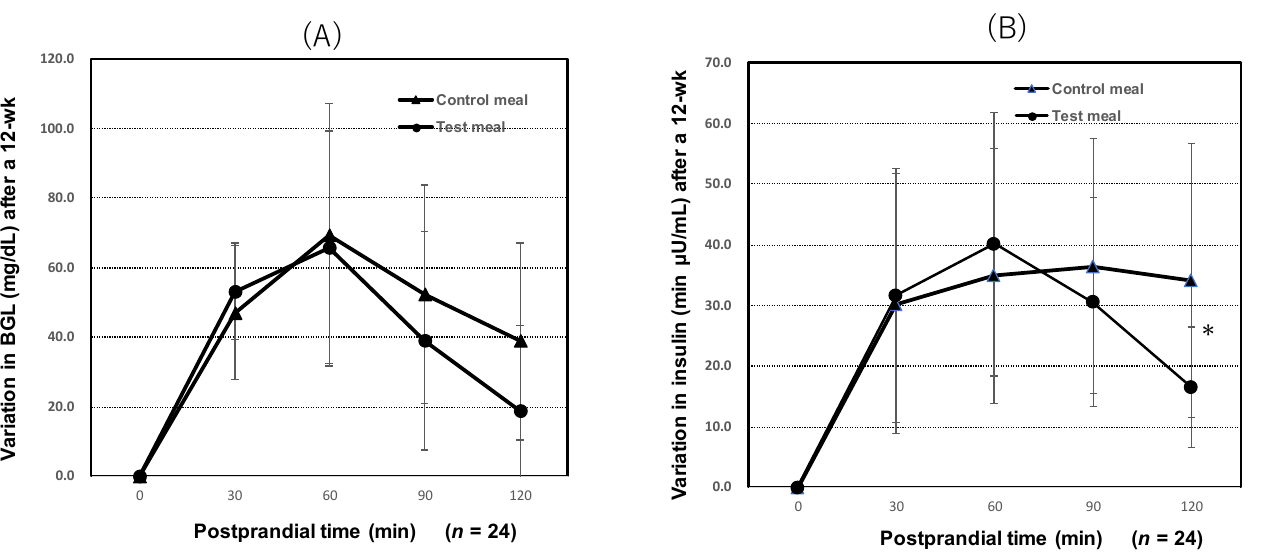
Figure 4. Variation in the BGL and insulin in 24 subjects after eating blending cooked rice of test meal (WFBSK) and polished rice of control after 12 weeks. ( A ) variation in postprandial BGL. ( B ) variation in postprandial insulin secretion. * means significant difference ( p < 0.05).